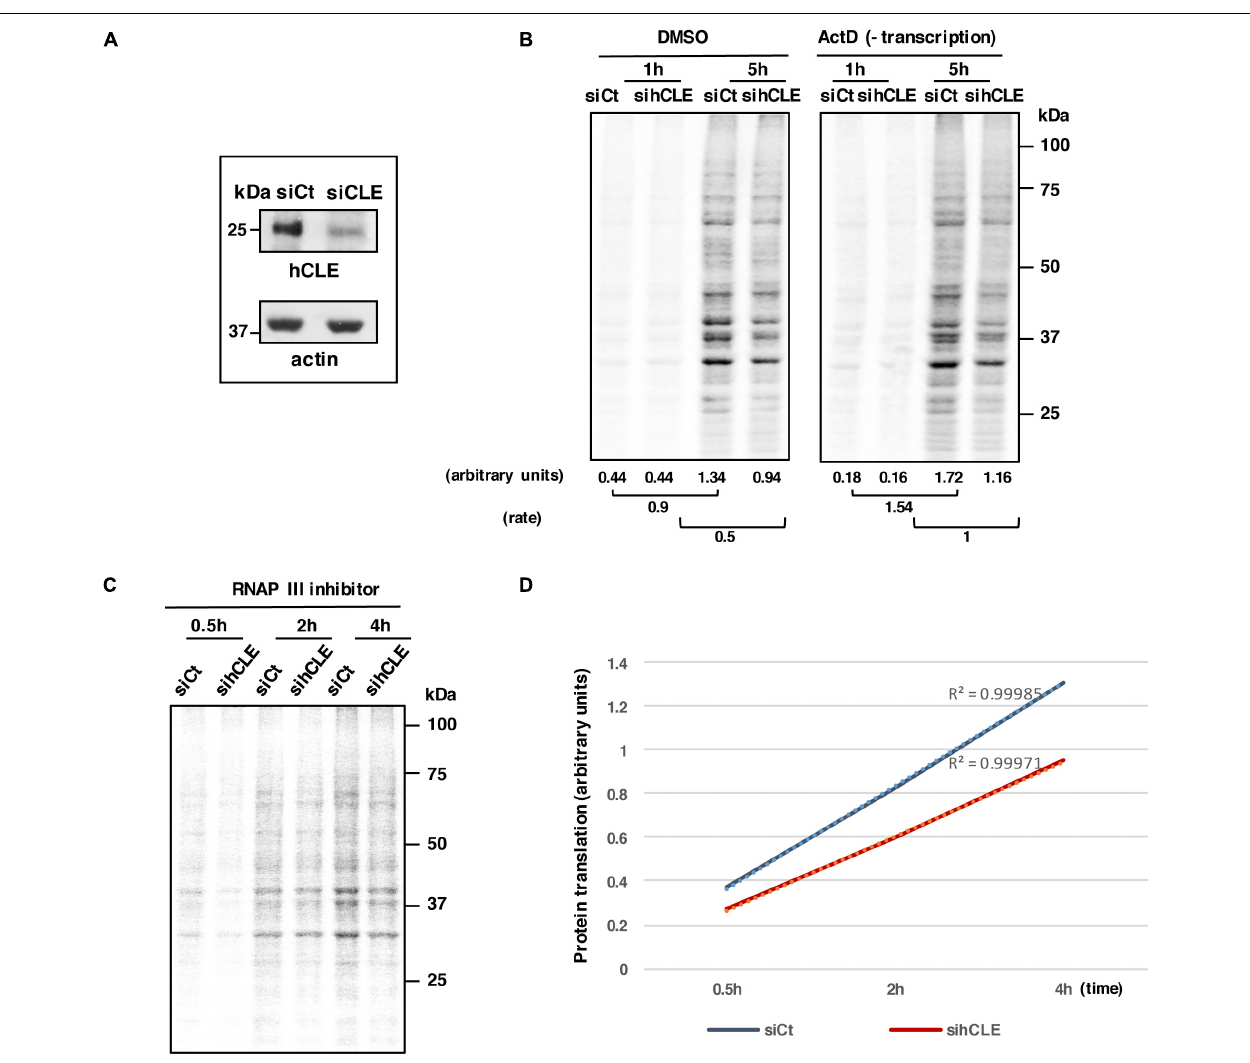
FIGURE 5 | hCLE controls RNA translation. HEK293T cells were infected with lentivirus expressing a control siRNA (siCt) or a siRNA that targets hCLE (siCLE). (A) Western blot detection of hCLE in control or silenced cells. (B) HEK293T cells were infected with control (siCt) or a siRNA that targets hCLE lentiviruses. Control or silenced HEK293T cells were cultured in Met/Cys-depleted DMEM (30 min); cells were untreated (DMSO) or actinomycin D (Act D)-treated (30 min), followed by 35 S-Met-Cys addition (time 0). At the indicated times aliquots were taken and used for SDS-gels and quantitated using ImageJ application (bottom). Rate represents the differences between signals obtained at 1h after 35 S-Met-Cys addition and those obtained at 5 h. A representative image is shown. The experiment was repeated three times. (C) HEK293T cells were infected with lentivirus expressing a control siRNA (siCt) or a siRNA that targets hCLE. Control or silenced HEK293T cells were cultured in Met/Cys-depleted DMEM (30 min) and then treated with 80 µ M of RNAP III inhibitor followed by 35 S-Met-Cys addition (time 0). At the indicated times aliquots were taken and used for SDS-gels and quantitated using ImageJ application. A representative image is shown. (D) Quantitation of data obtained from part C. The experiment was repeated two